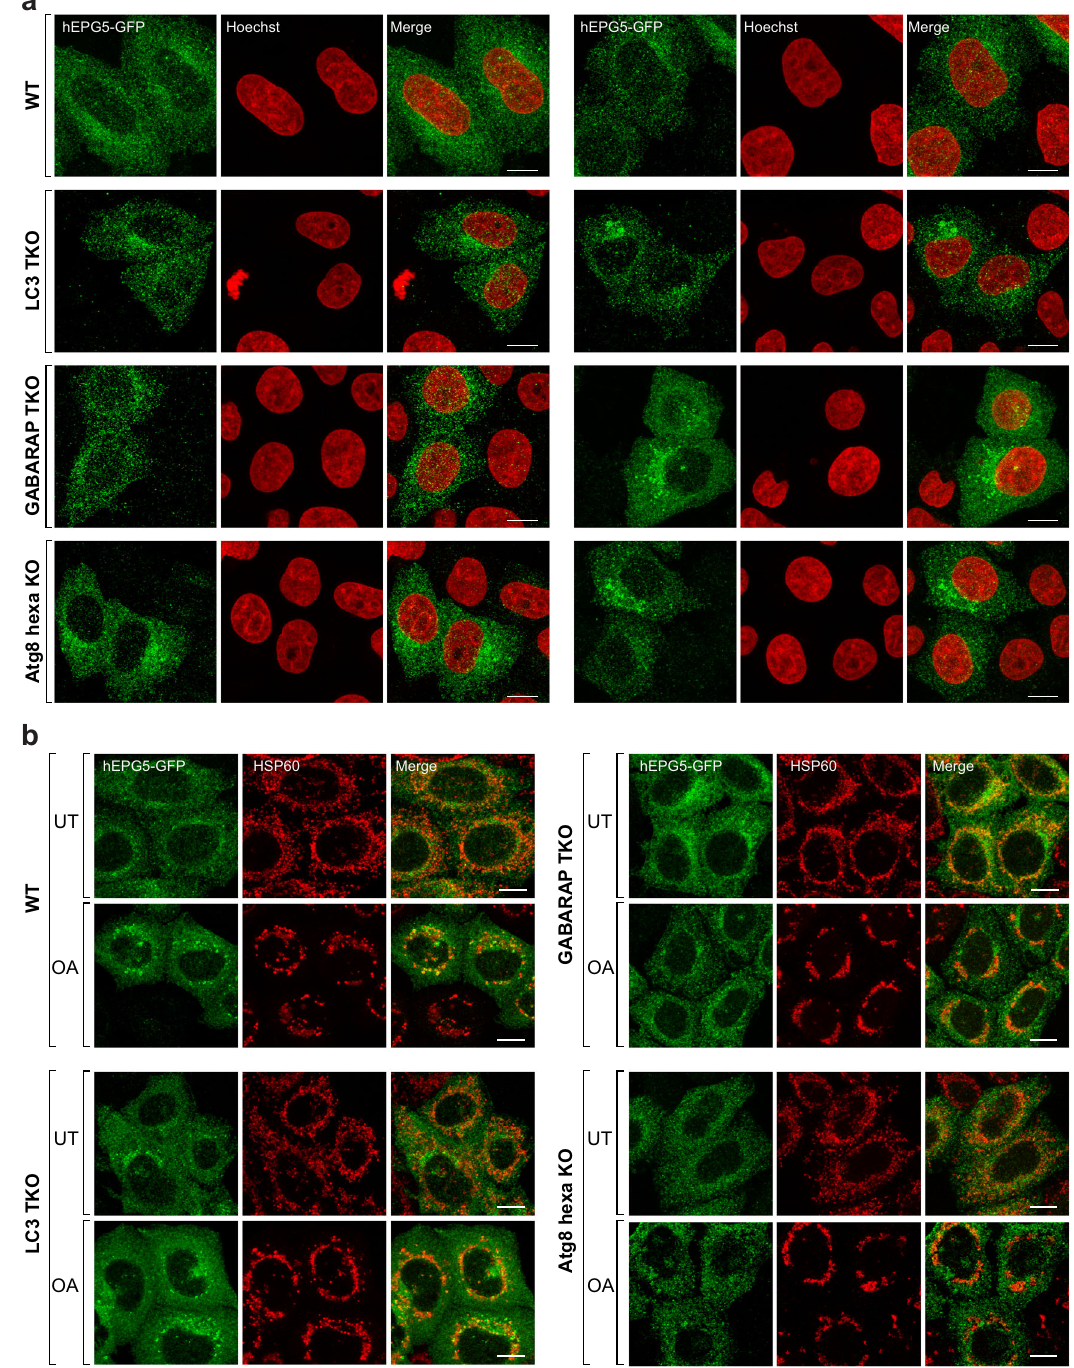
Fig. 5 hEPG5 localizes to mitochondria in a GABARAP-dependent manner upon activation of Pink1/Parkin-dependent mitophagy. a , b Wild type (WT), LC3-triple knockout (TKO), GABARAP-TKO, and ATG8-hexaKO expressing mCherry-Parkin were transfected with hEPG5-GFP overnight and subsequently seeded on coverslips to grow for further 48 h. a Cells were subjected to immuno fl uorescence assay (IFA) with anti-GFP antibodies and Hoechst and subsequent imaging by confocal microscope. b Cells were left untreated or treated for 3 h with 10 µ M oligomycin, 4 µ M antimycin A, and 5 µ M qVD prior to antibody staining with anti-GFP and anti-mitochondrial HSP60 antibodies and confocal microscopy analysis. Scale bars: 10 μ